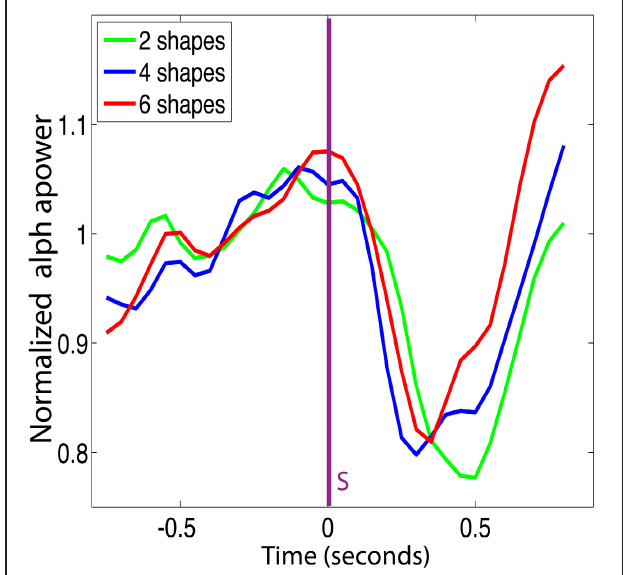
FIGURE 4 | Time-course of alpha power around stimulus appearance depends on number of shapes seen. Average normalized alpha power (non-baselined) for the electrodes identified from Figure 3C as showing a significant correlation with reaction-time during the period after stimulus presentation. Purple vertical line at 0 marks stimulus appearance. Green, blue, and red curves represent, respectively, the time-course for 2, 4, and 6 shapes. Latency of the minimum value for 2 shapes is significantly slower than for 4 or 6 shapes.